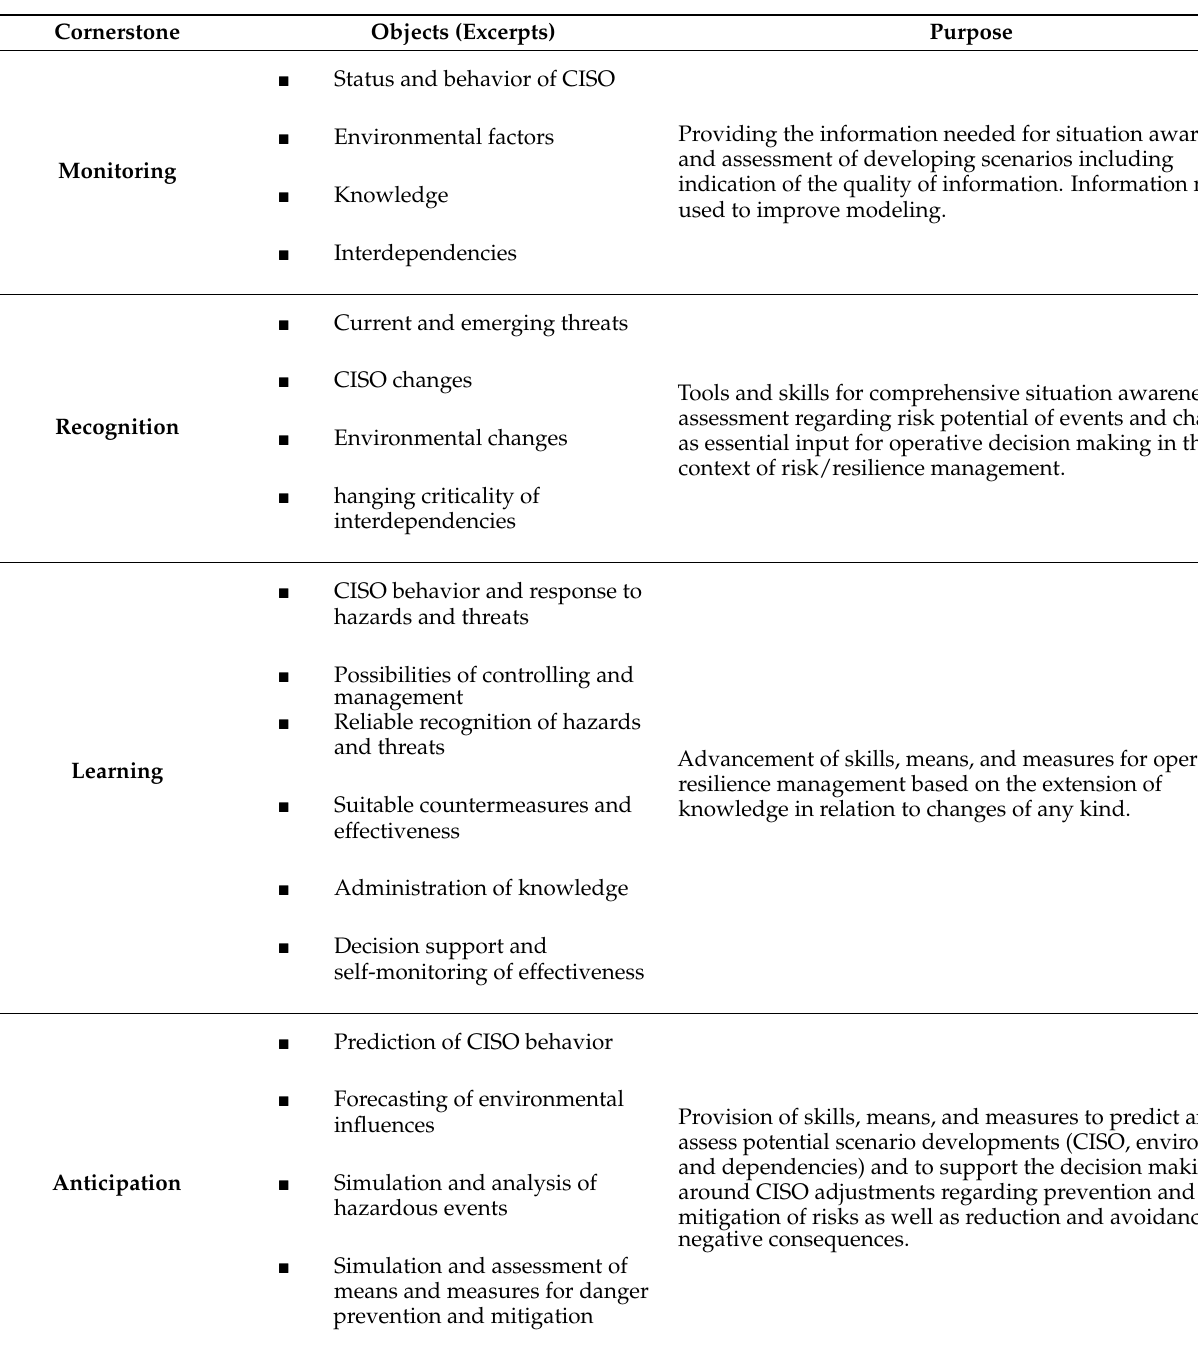
Table 1. Requirements for operational resilience management based on Hollnagel’s four